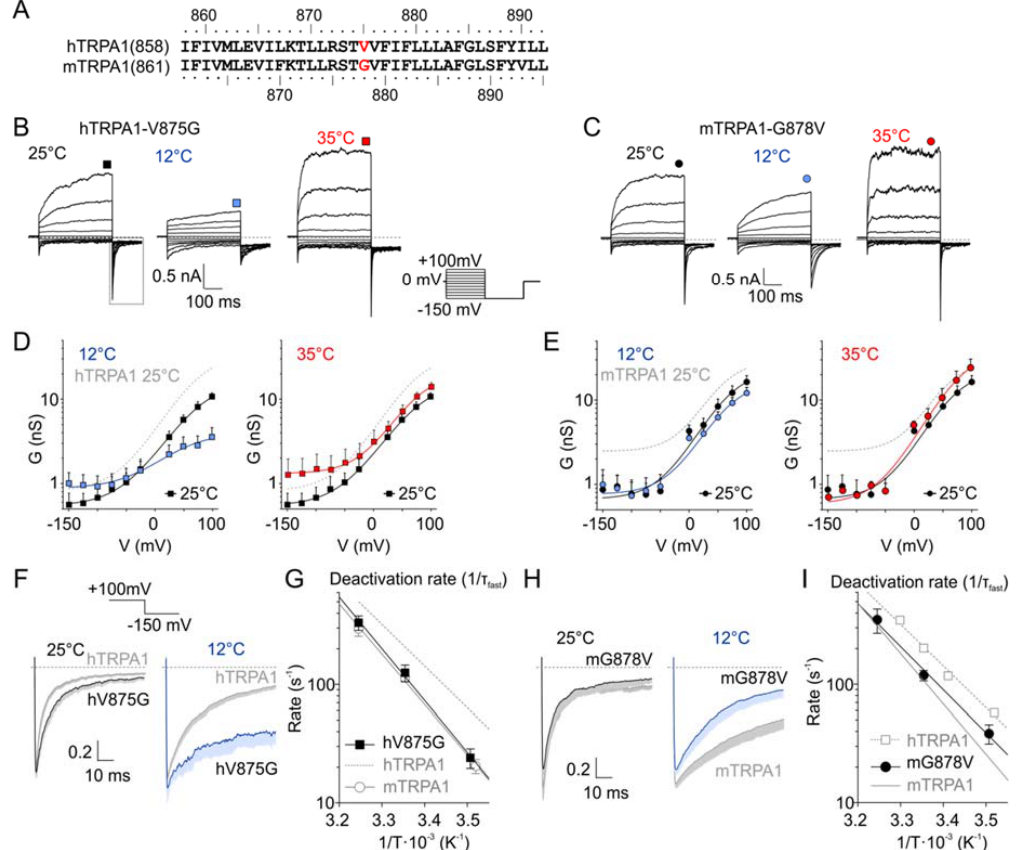
Figure 2. A single residue in S5 is involved in the species-specific di ff erences in temperature sensitivity. ( A ) Sequence alignment of the fifth transmembrane domain (S5) of human and mouse TRPA1. The residues V875 (hTRPA1) and G878 (mTRPA1) underlying the species-specific di ff erences in cold sensitivity are marked in red. ( B ) Representative whole-cell currents in Ca 2 + -free intracellular and extracellular solutions recorded from a human embryonic kidney (HEK) 293T cell line transiently expressing the human-to-mouse mutation hTRPA1-V875G, measured by the indicated voltage-step protocol at di ff erent temperatures. Steady-state currents were measured at the end of the pulses, as indicated by colored symbols atop each record. Dashed lines indicate zero current. ( C ) Representative whole-cell currents of mouse-to-human mutation mTRPA1-G878V, as in ( B ). ( D ) Average conductance of hTRPA1-V875G obtained from voltage step protocols, as in ( B ). The data represent the means + SEM. ( n = 7). The solid lines represent the best fit to a Boltzmann function, as described in Materials and Methods. The fit of hTRPA1 at 25 ◦ C is included as grey dashed line for comparison. ( E ) Average conductance of mTRPA1-G878V obtained from voltage step protocols, as in ( C ). The data represent the means + SEM. ( n = 4). The solid lines represent the best fit to a Boltzmann function, as described in Materials and methods. The fit of mTRPA1 at 25 ◦ C is included as grey dashed line for comparison. ( F ) Deactivation kinetics of hTRPA1-V875G compared with hTRPA1 acquired at 25 ◦ C (left) and 12 ◦ C (right). Average tail currents normalized to the maximum amplitude at + 100 mV, obtained as an indicated part of the voltage-induced currents, as in ( B ); dashed box. The average currents are shown with gray or blue bars that indicate means –SEM. ( n = 5). ( G ) Arrhenius plots of fast deactivation time constants of hTRPA1-V875G (black squares). The linear regression (black line) is steeper than that of hTRPA1 (gray dashed line) and resembles that of mTRPA1 (gray open circles and gray line). Error bars are SEM. ( n = 5). ( H ) Deactivation kinetics of mTRPA1-G878V mutant compared with mTRPA1 acquired at 25 ◦ C (left) and 12 ◦ C (right), as in ( C ). Error bars are SEM. ( n = 4). ( I ) Arrhenius plots of fast deactivation time constants of mTRPA1-G878V (black circles). The linear regression (black line) is less steep than that of mTRPA1 (gray line), and its steepness resembles that of hTRPA1 (grey squares and gray dashed line). Error bars are SEM ( n =